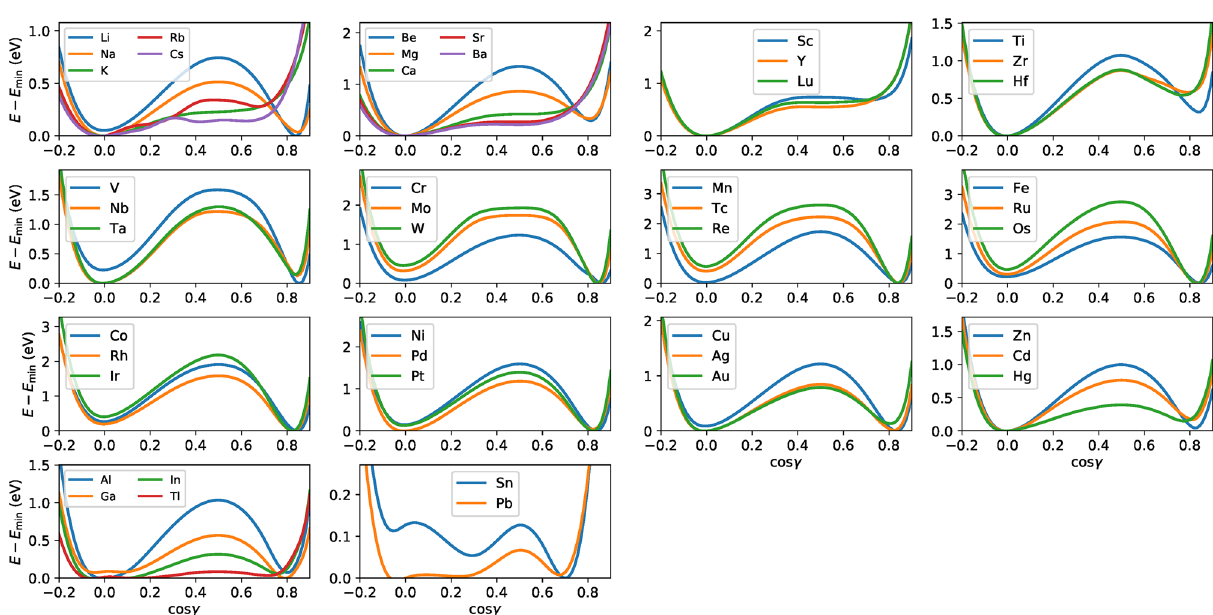
Figure 6. The total energy per a cell as a function of cos γ (the trigonal path) for Cu X